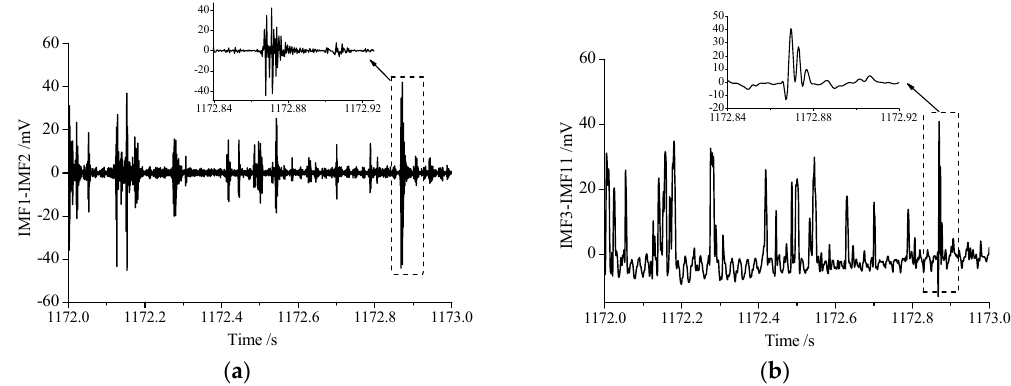
Figure 11. High-frequency and low-frequency components of MS in 1172.0–1173.0 s at the XI stage. ( a ) High-frequency component and ( b ) low-frequency